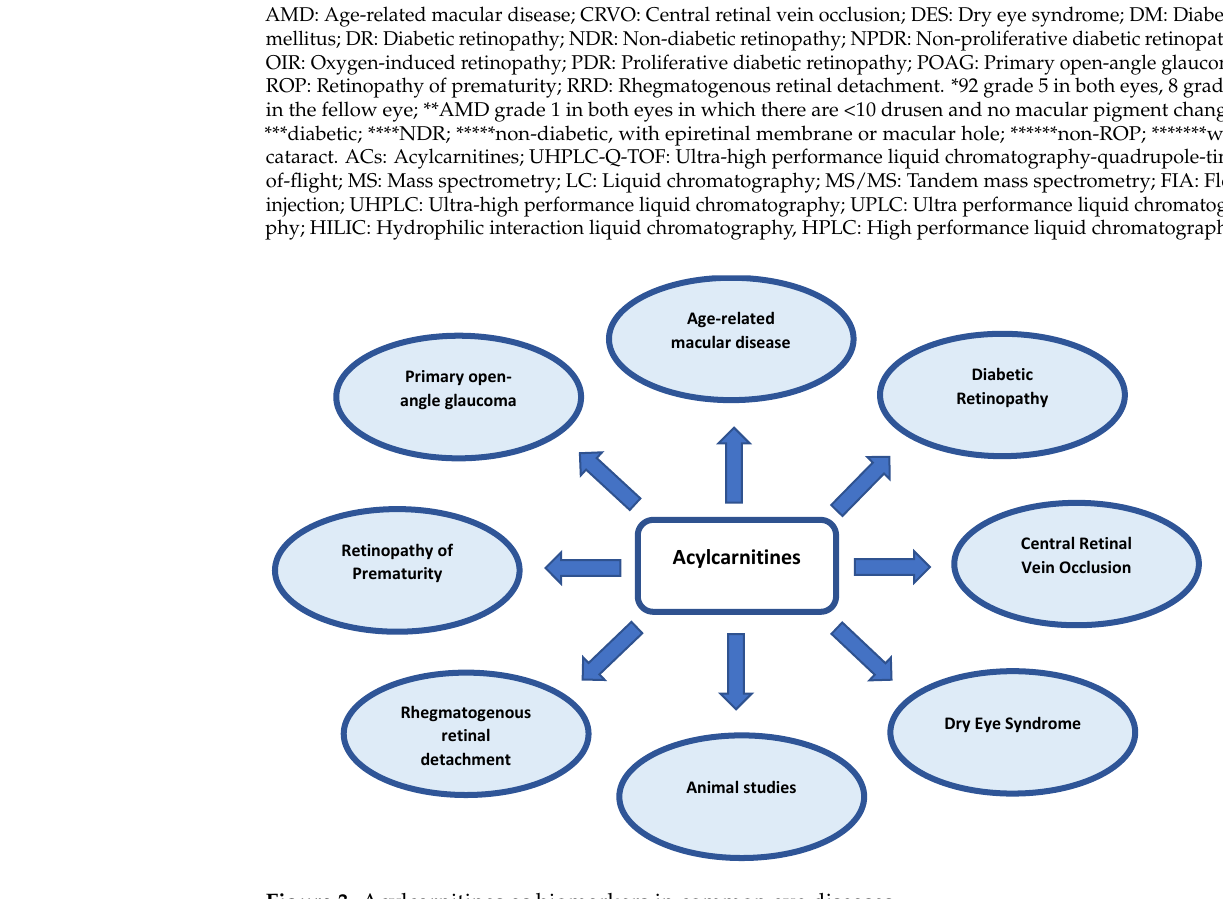
Figure 3. Acylcarnitines as biomarkers in common eye diseases.